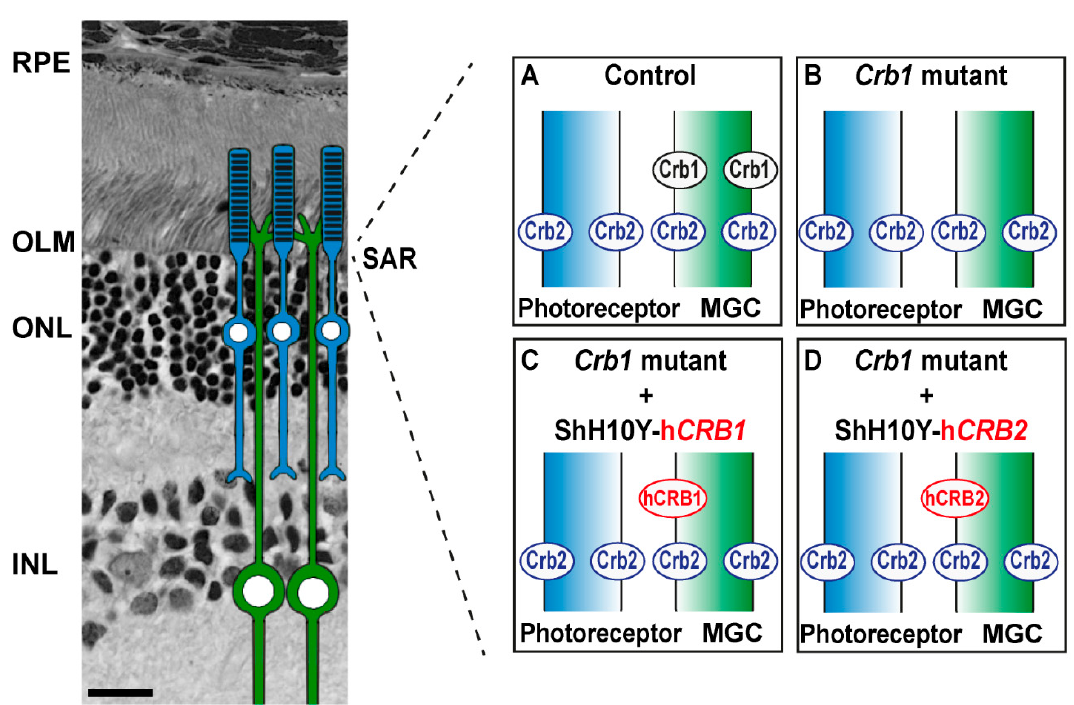
Figure 5. Graphical representation of subcellular localization of Crb1 and Crb2 proteins in Brown Norway rat retina and gene therapy approach using ShH10Y-h CRB1 and ShH10Y-h CRB2 . Graphical representation of the subcellular localization of Cb1 and Crb2 in control ( A ) and Crb1 mutant ( B ) rat retinas. Graphical representation using AAV-mediated gene therapy vectors targeting MGCs using ShH10Y-h CRB1 ( C ) and ShH10Y-h CRB2 ( D ). Scale bar: 20 µm. RPE = retinal pigment epithelium; OLM = outer limiting membrane; ONL = outer nuclear layer; INL = inner nuclear layer; SAR = subapical region; MGC = Müller glial cell.